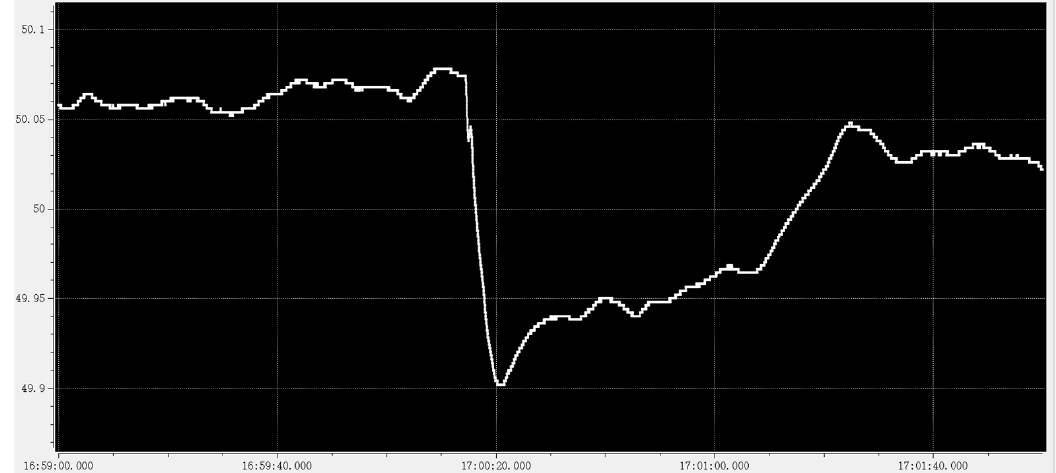
Figure 5. The frequency change curve of low-frequency disturbance test system.